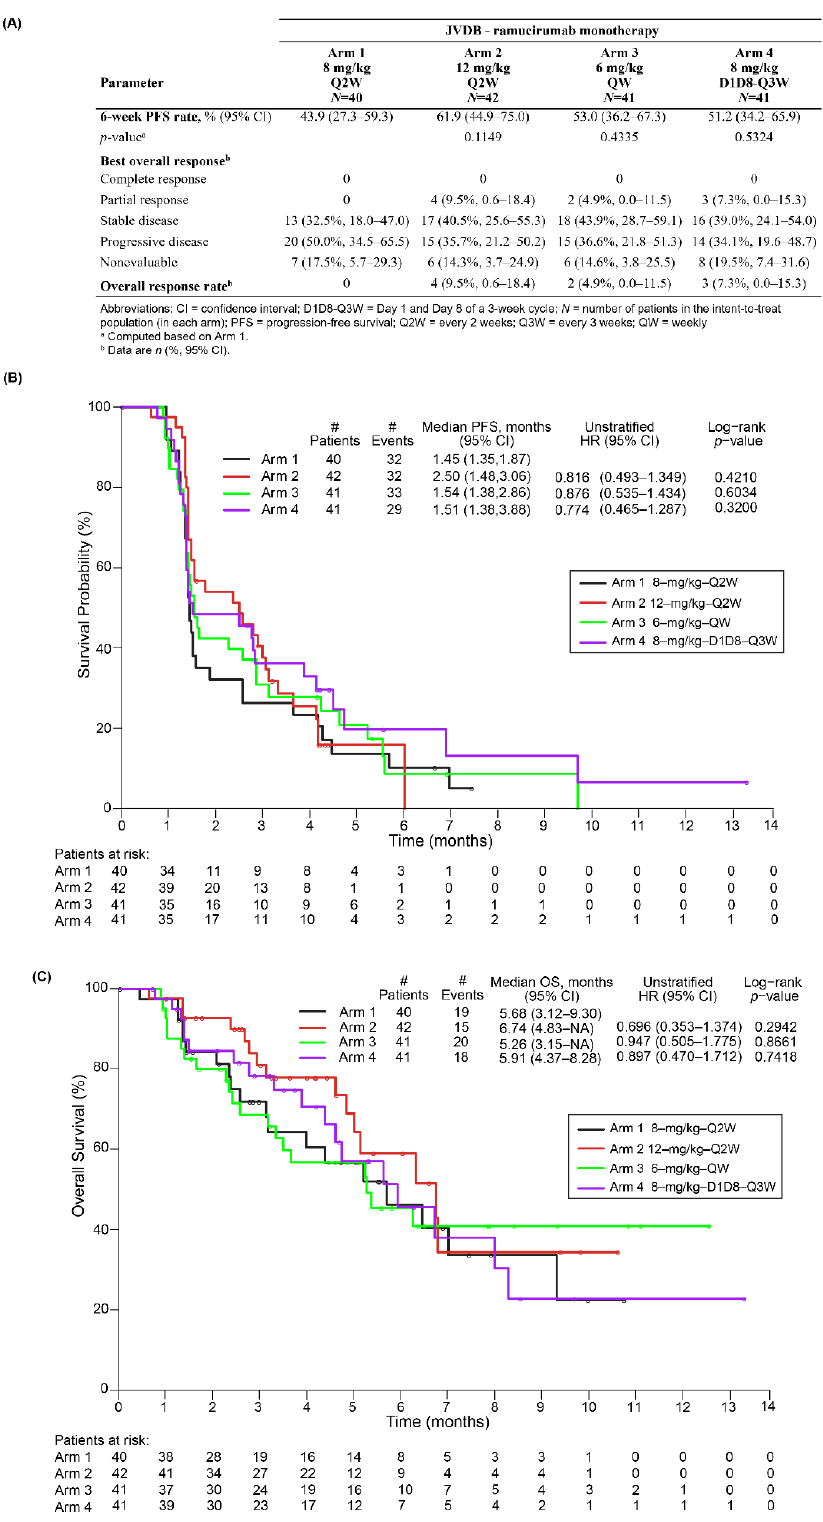
Figure 2. Six-week PFS and objective responses ( A ), PFS ( B ), and OS ( C ) for the standard regimen (Arm 1) and the 3 EDRs (Arms 2, 3 and 4) of ramucirumab monotherapy (JVDB). Abbreviations: EDRs—exploratory dosing regimens; OS—overall survival; PFS—progression-free survival.